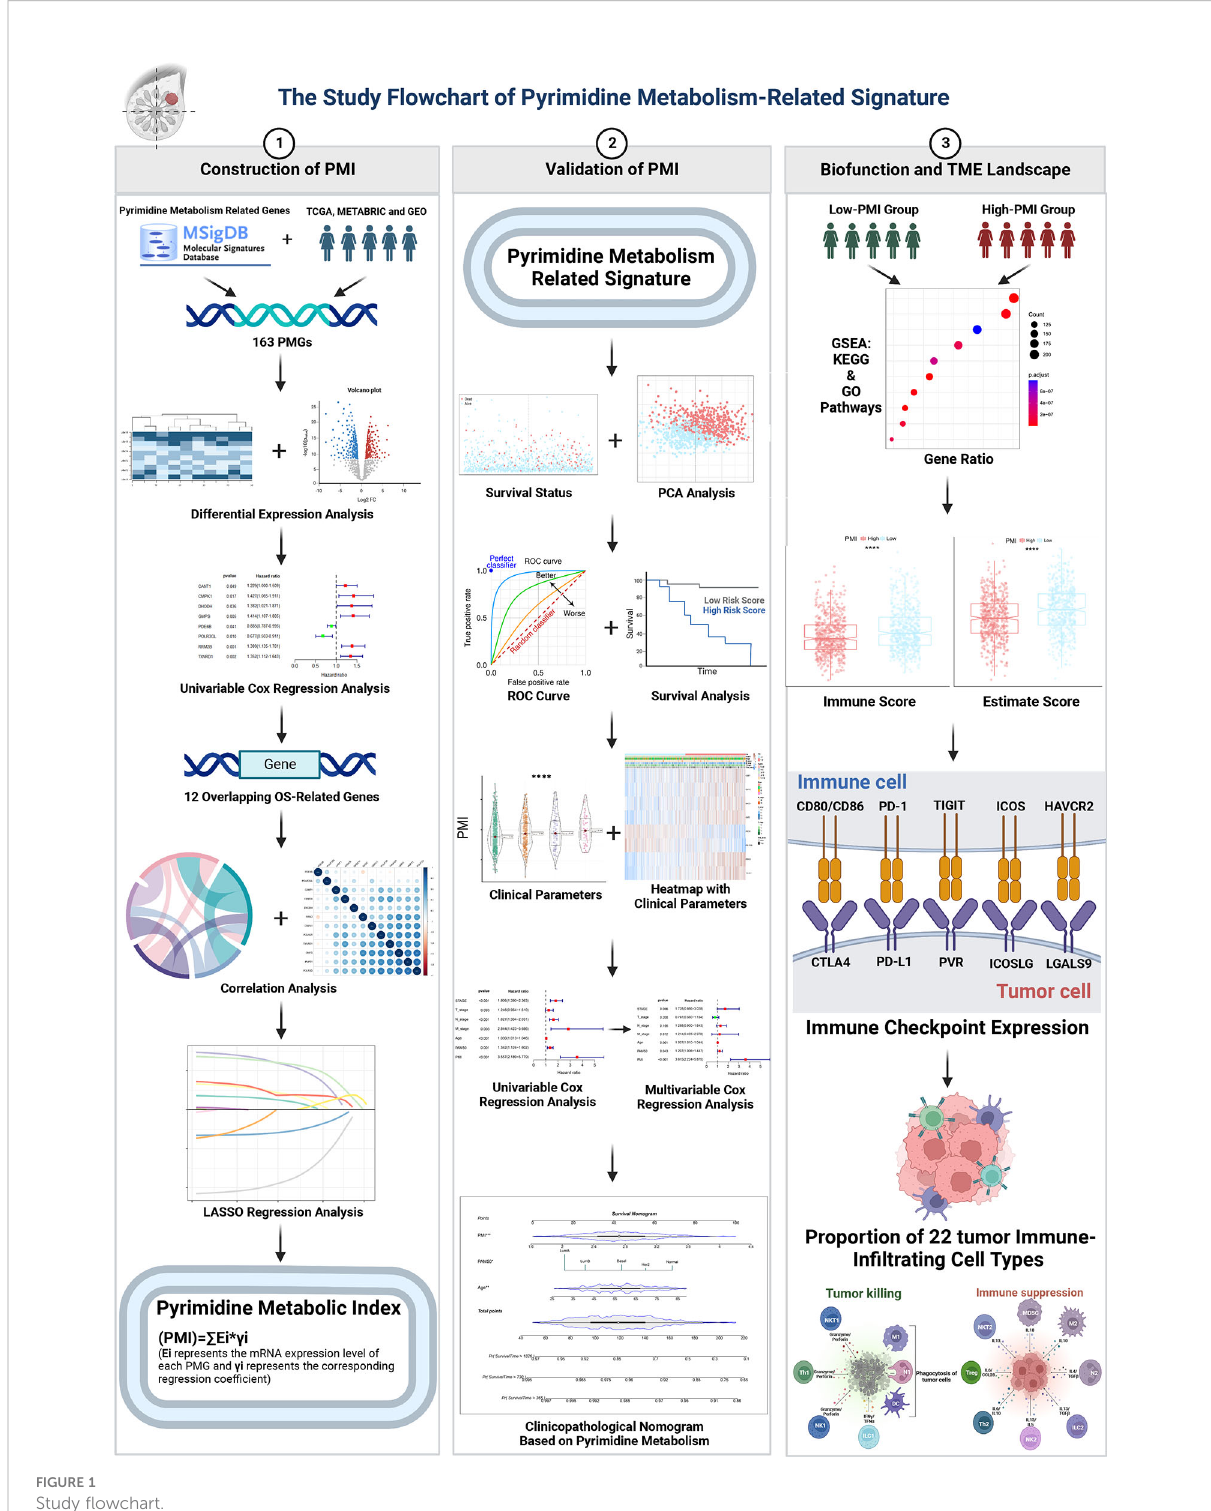
FIGURE 1 Study fl